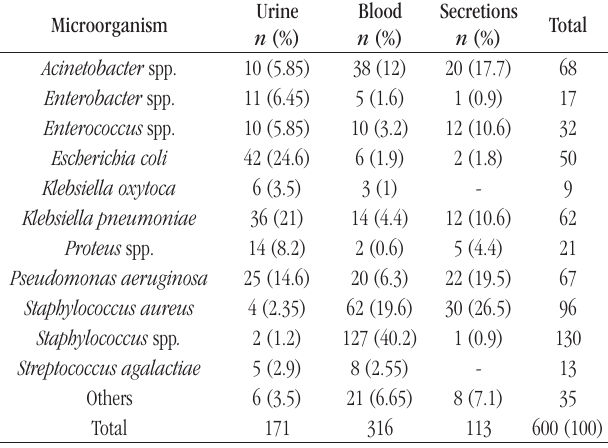
taBLE 2 − Prevalence of microorganisms per sample Microorganism